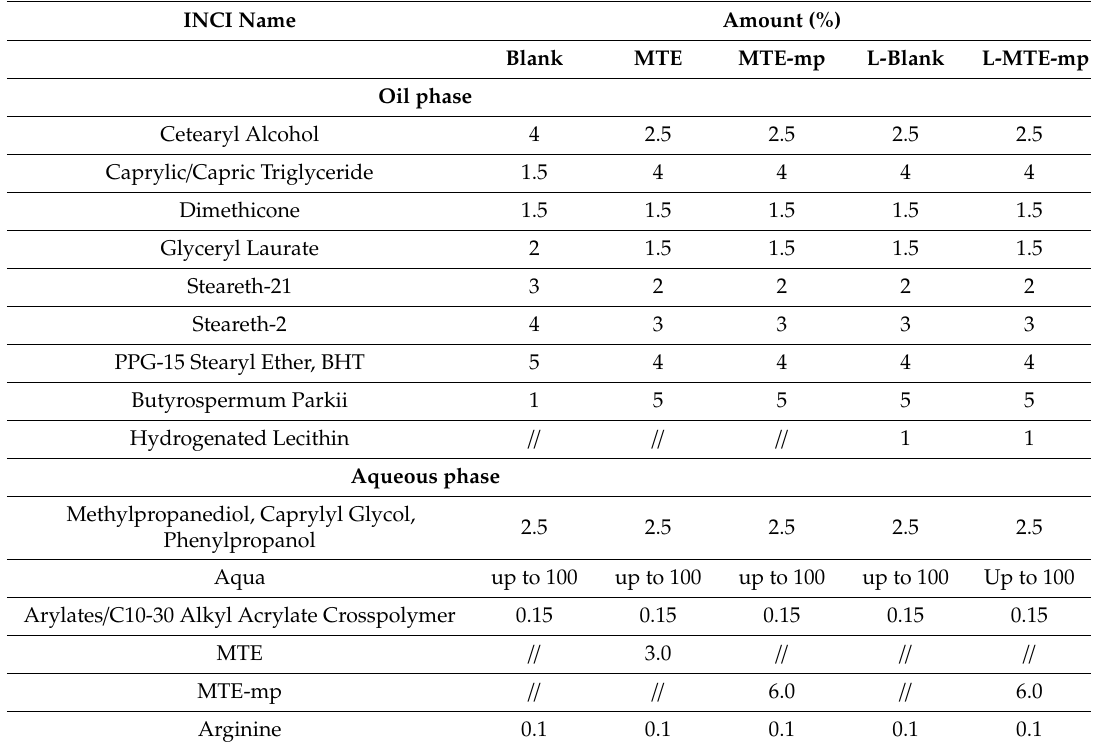
Table 4. Components of